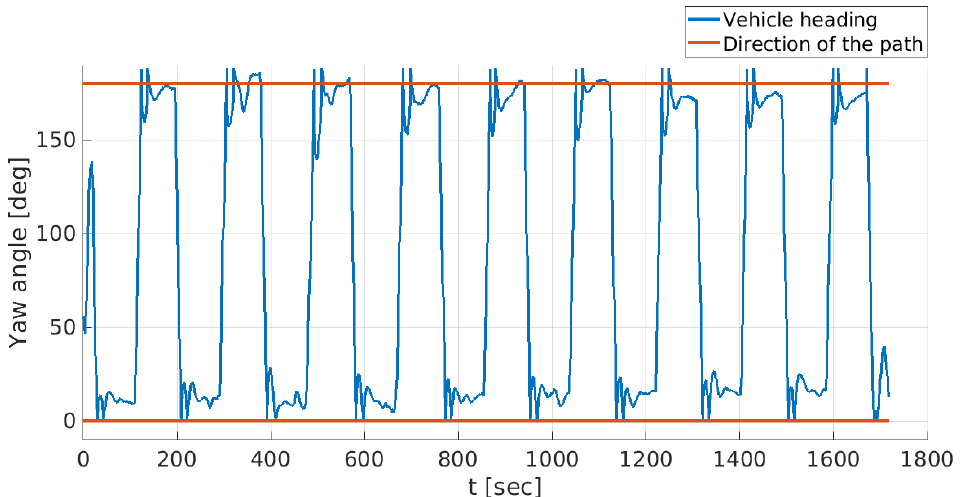
Figure 27. Vehicle’s heading during the mission, employing the SPARUS II configuration. The direction of the survey transects was defined from/to North to/from South (0–180).